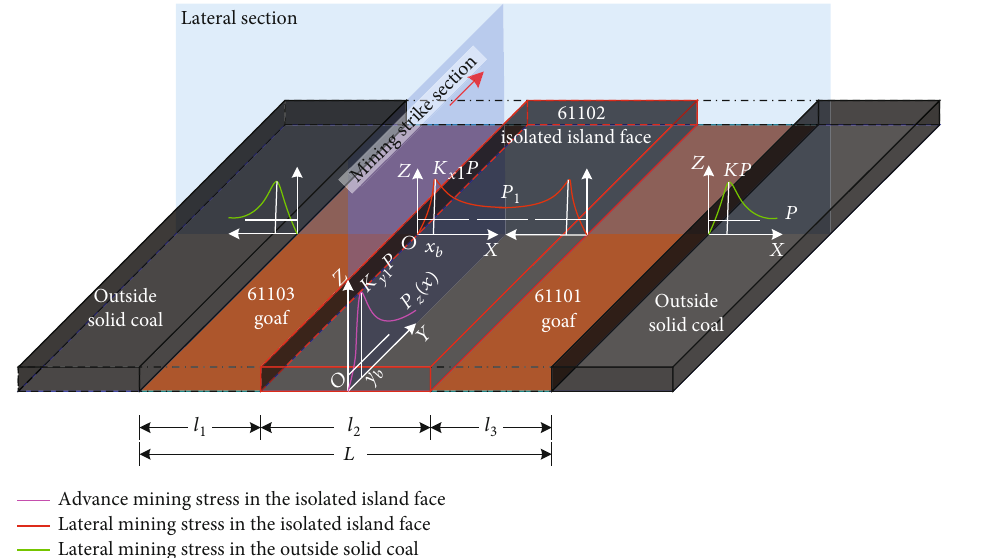
Figure 5: Distribution characteristics of mining stress in the coal – rock mass in the isolated island face in fully mechanized top-coal caving mining.